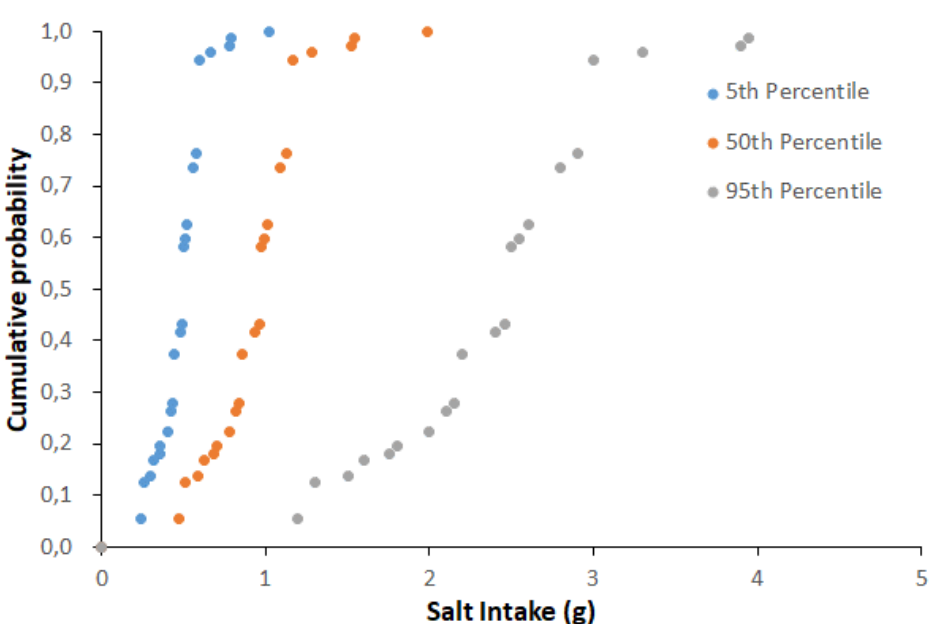
Figure 3. Cumulative probability of saturated fat (g) intake per capita and per day of Greek adults’ consuming feta cheese marketed in the Greek market for the fifth, 50th and 95th percentiles of daily consumption.